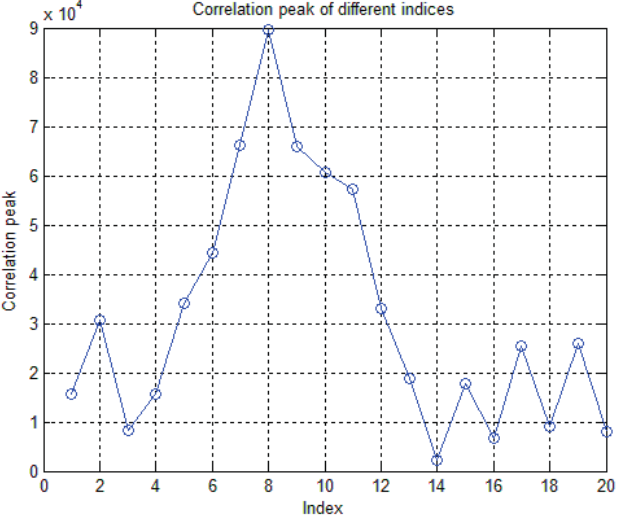
Figure 3. Acquisition correlation peaks for different NH